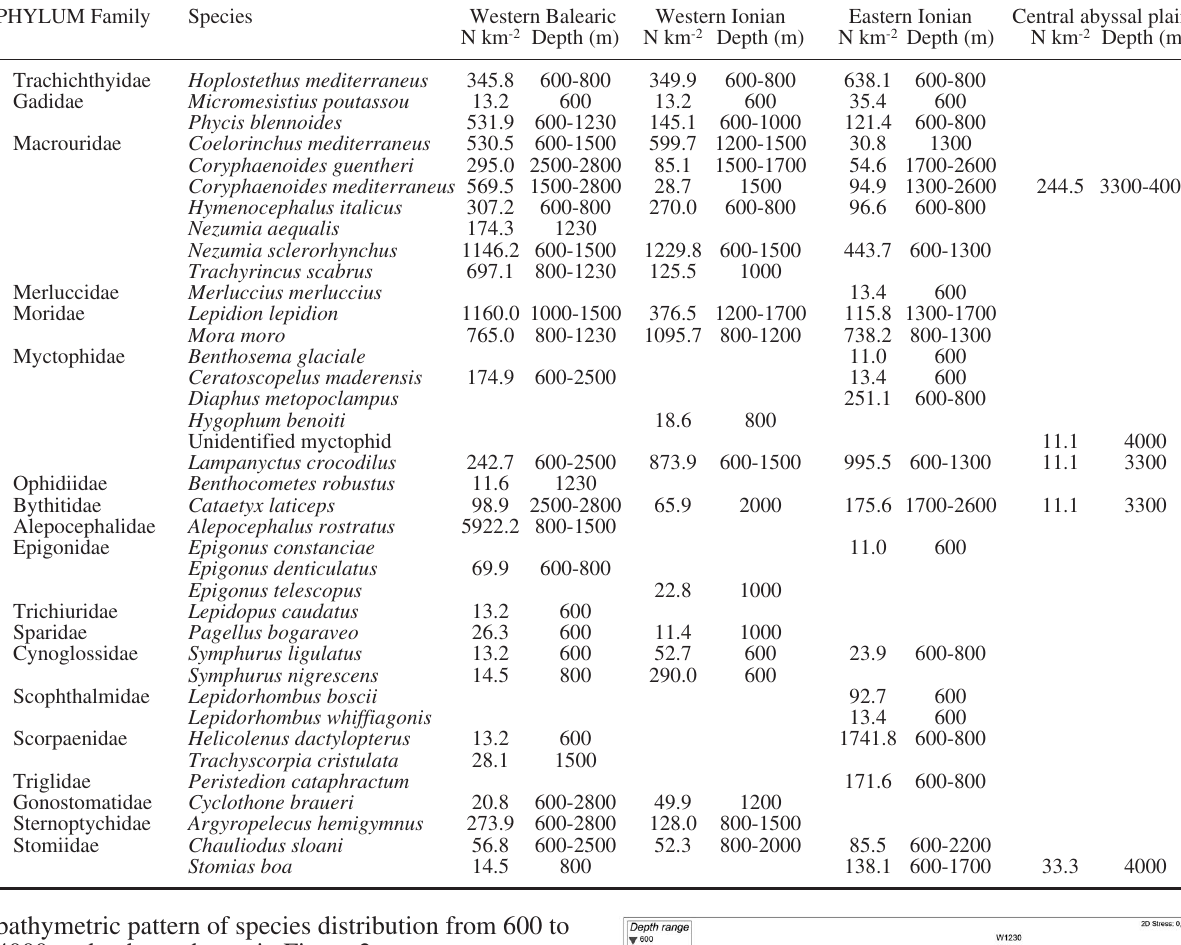
Table 2 (cont.). – Species list of demersal megafauna sampled in the DESEAS cruise, along with their total collected abundance in each of the four samples areas, and their depth range of catch.